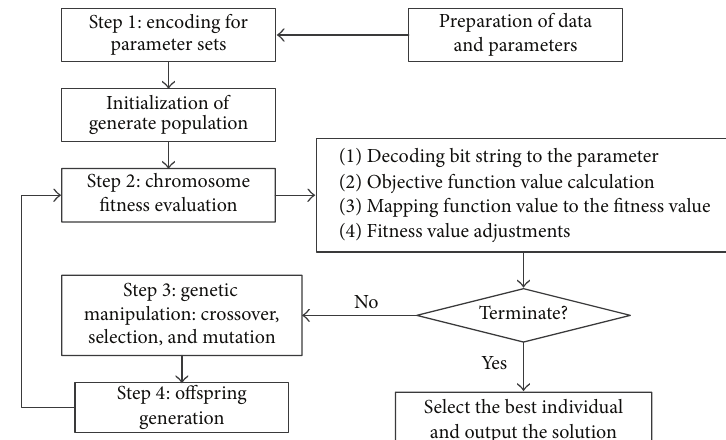
Figure 3: Steps of the proposed GA heuristic.